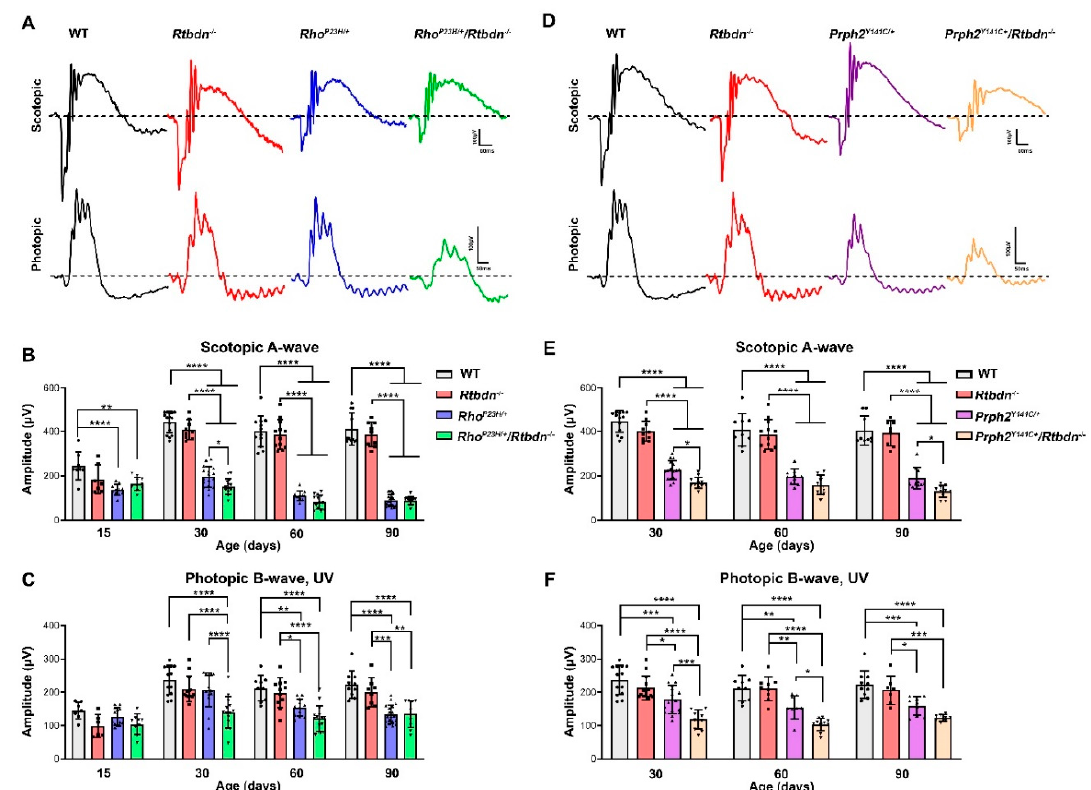
Figure 6. Rtbdn elimination exacerbates functional decline in degenerative models. ( A , D ) Shown are representative scotopic and photopic waveforms recorded at P30. ( B , E ) Maximum scotopic A-wave amplitudes are plotted as mean ± SD from recordings taken at the indicated ages/genotypes. ( C , F ) Maximum photopic B-wave amplitudes are plotted as mean ± SD. n = 10 − 19 animals for each genotype/age. * p < 0.05, ** p < 0.01, *** p < 0.001, **** p < 0.0001 by two-way ANOVA with Sidak’s post hoc test. Symbols represent individual animals.